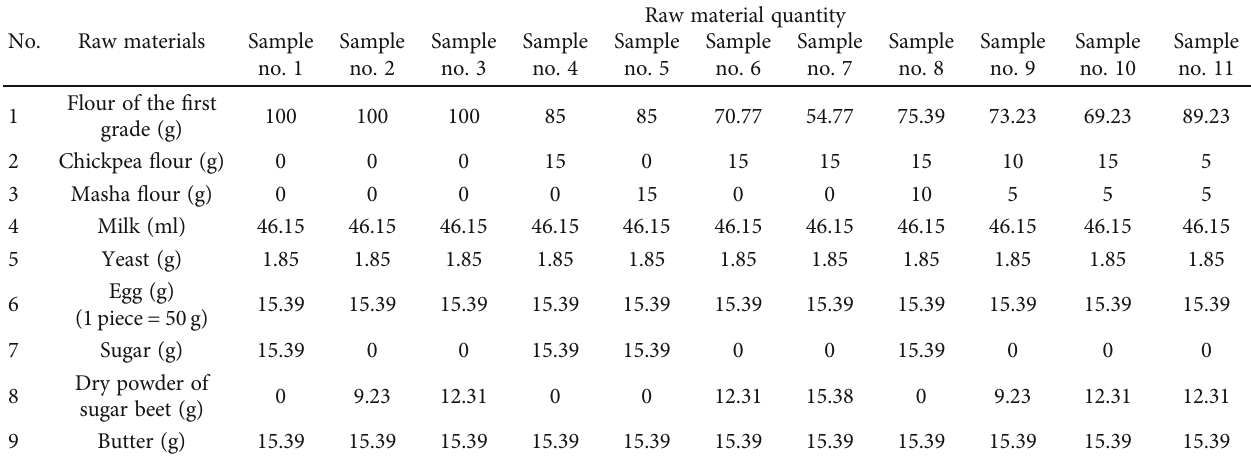
Table 2: Recipes of the control sample and new assortments of buns, calculated for 100g of fl our.